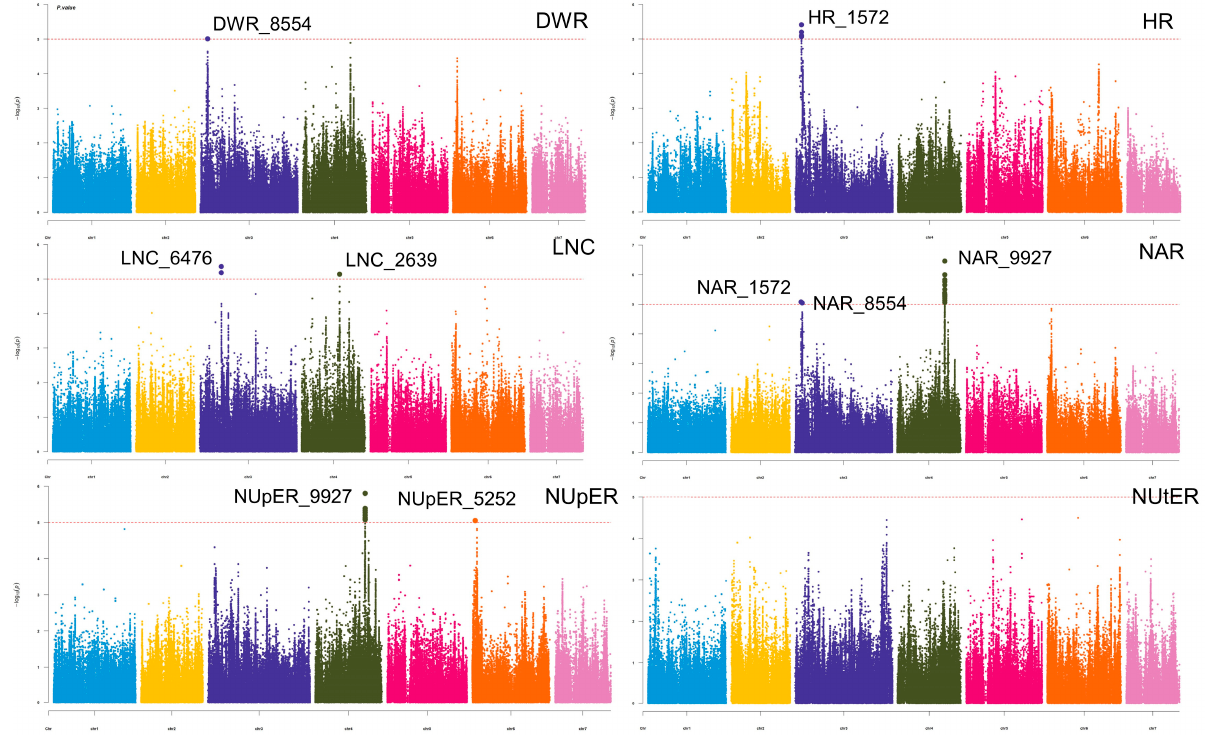
Figure 3. GWAS Manhattan plots of low-nitrogen tolerance in six traits. the color blue, yellow, dark blue, black, rose red, orange, and pink represent each SNP located in chromosomes 1-7, respectively. The vertical axis represents the calculated P-value of each SNP, which is -log10. The horizontal axis represents the chromosome where the SNP is located. Table 2. Details of Lead SNPs and LD BLOCK.